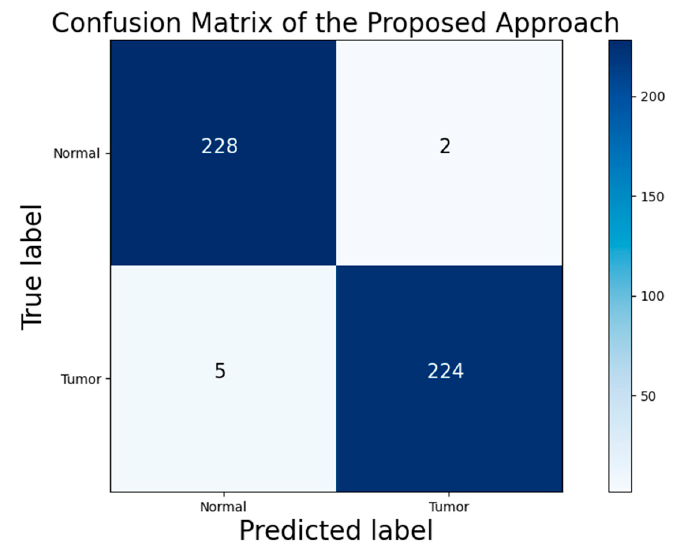
Figure 6. Confusion Matrix of the proposed